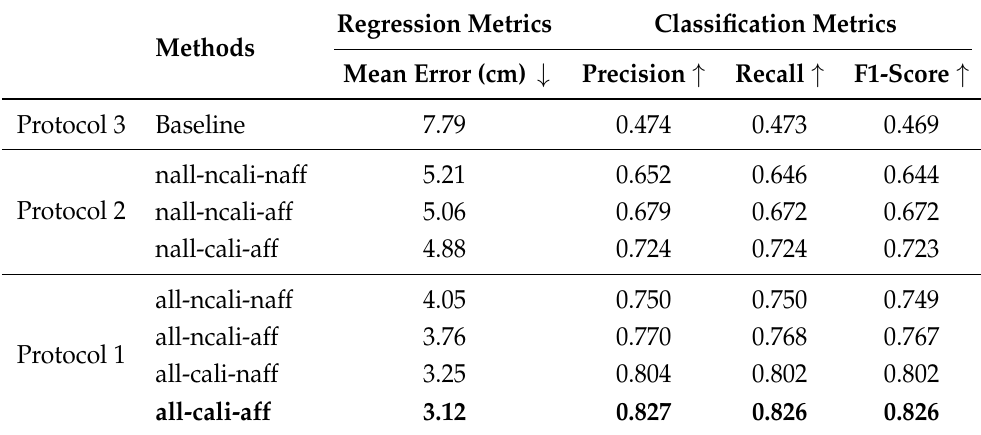
Table 1. Comparison between different protocols based on the different